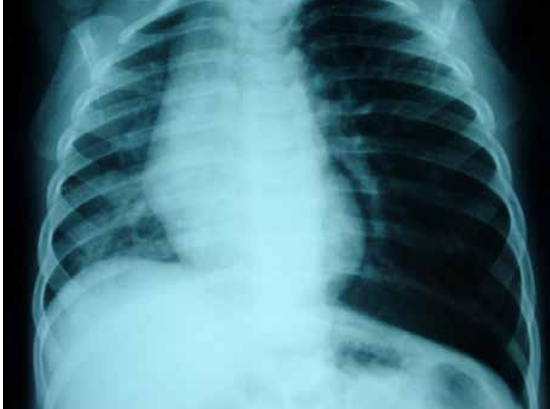
Figure 1. Left-sided shift of mediastinum, focal hyperinflation of left lung, and uprising of the right hemidiaphragm, sug- gesting the presence of a foreign body in the left bronchus.